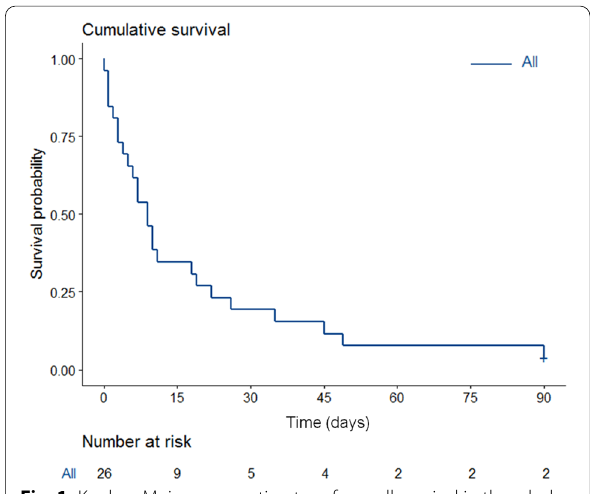
Fig. 1 Kaplan–Meier curve estimates of overall survival in the whole cohort